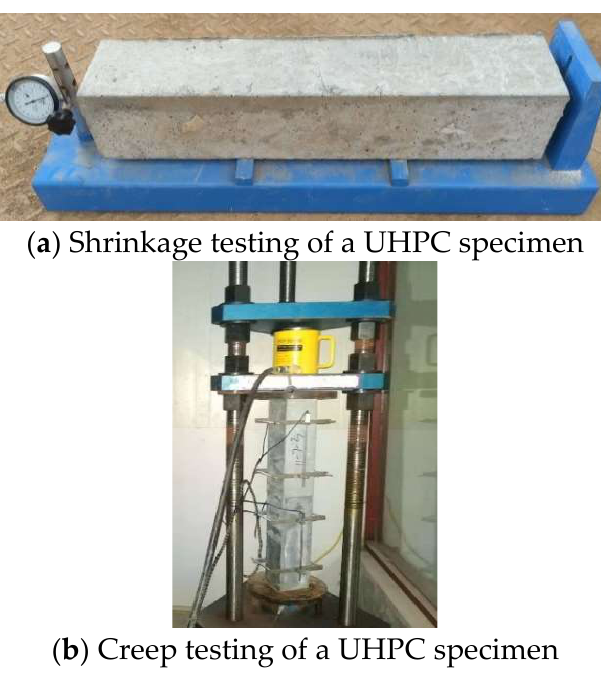
Figure 1. Shrinkage and creep-testing process of UHPC specimens.